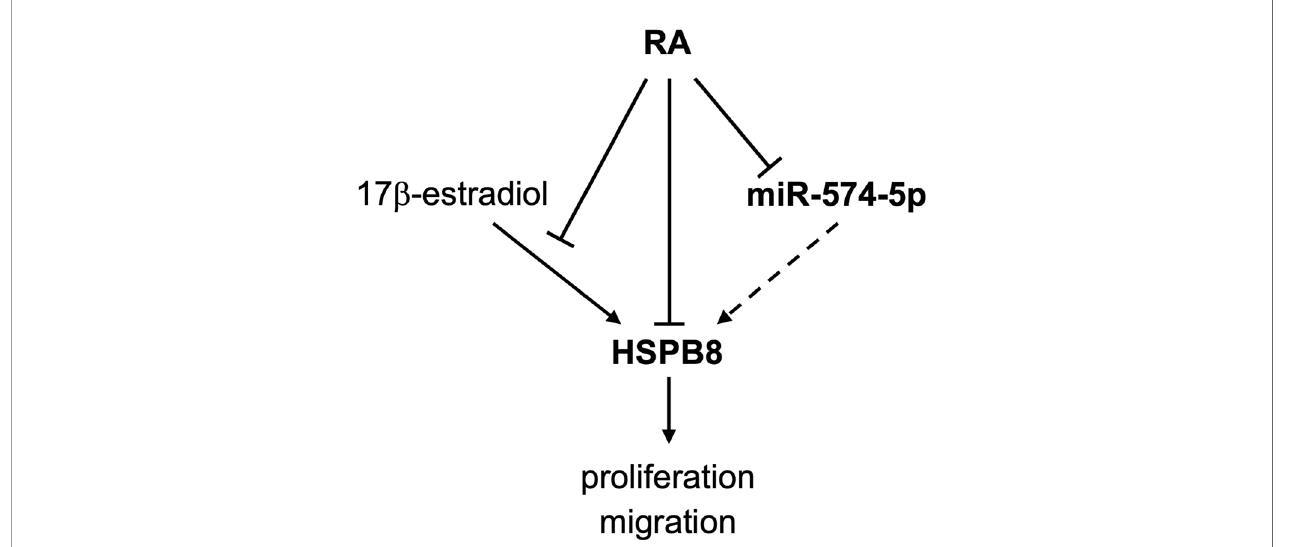
FIGURE 5 | Schematic representation of the RA effects on MCF-7 cells unveiled in this